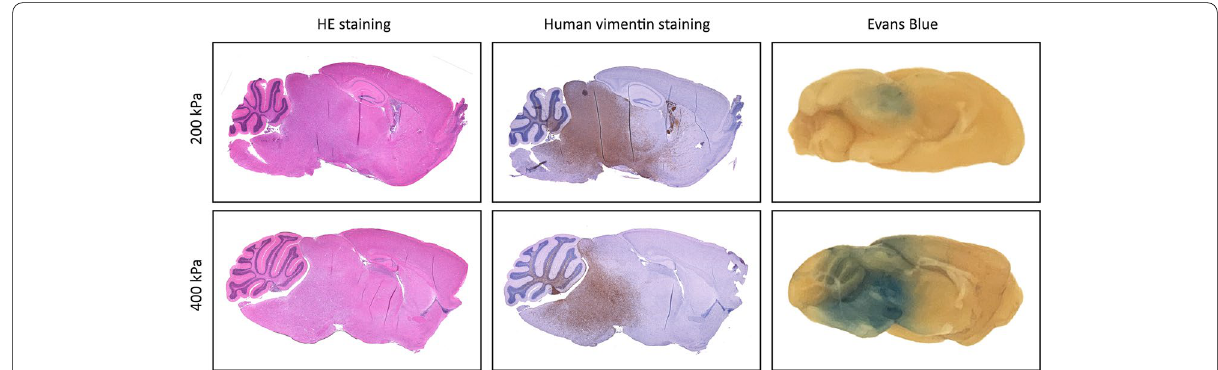
Fig. 3 Sagittal brain sections of FUS treated HSJD-DIPG-07 xenograft-bearing mice showing safety and BBB opening. Left: HE stainings indicating no tissue damage after FUS at 200 and 400 kPa. Middle: Human vimentin staining showing the diffuse growth pattern of HSJD-DIPG-07 xenograft. Right: Evans Blue extravasation after FUS showing an overlap with the human vimentin (tumor) staining at 400 kPa while at 200 kPa the tumor area is not